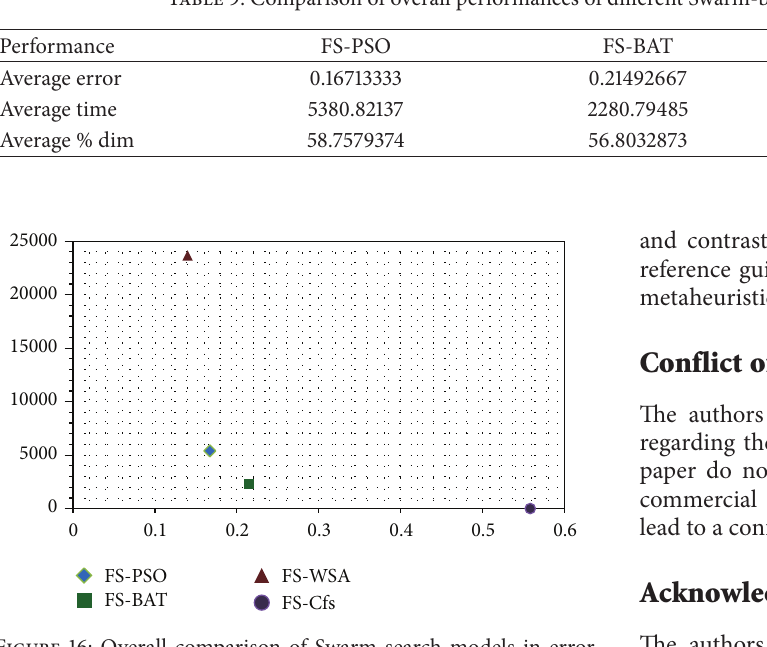
Figure 16: Overall comparison of Swarm-search models in error rates versus time